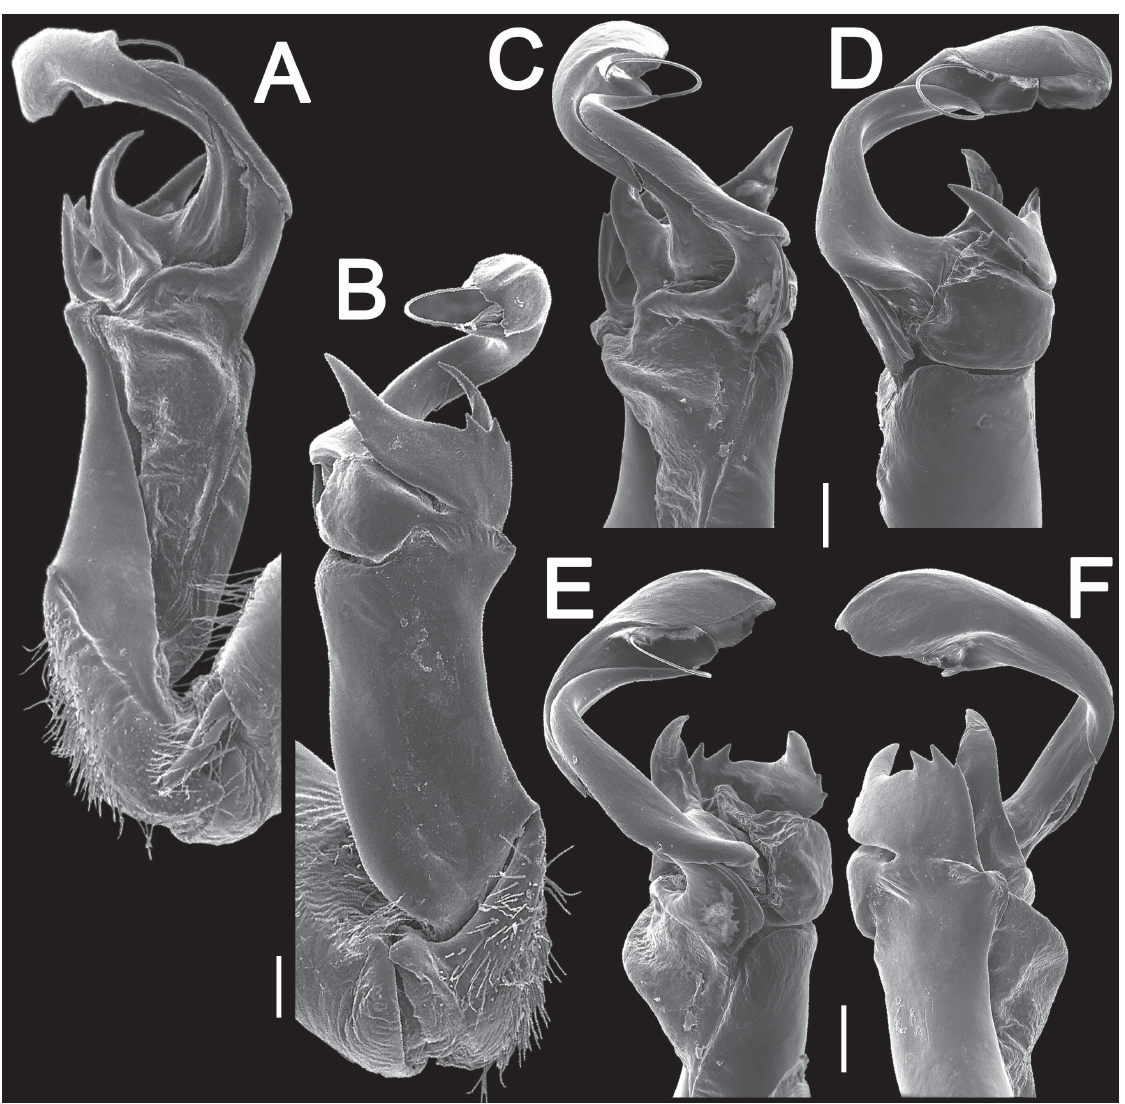
Fig. 25. Tylopus baenzigeri Golovatch & Enghoff, 1993, ♂, right gonopod. A–B . Mesal and lateral views, respectively. C–F . Distal part, submesal, sublateral, subcaudal and suboral views, respectively. Scale bar = 0.2